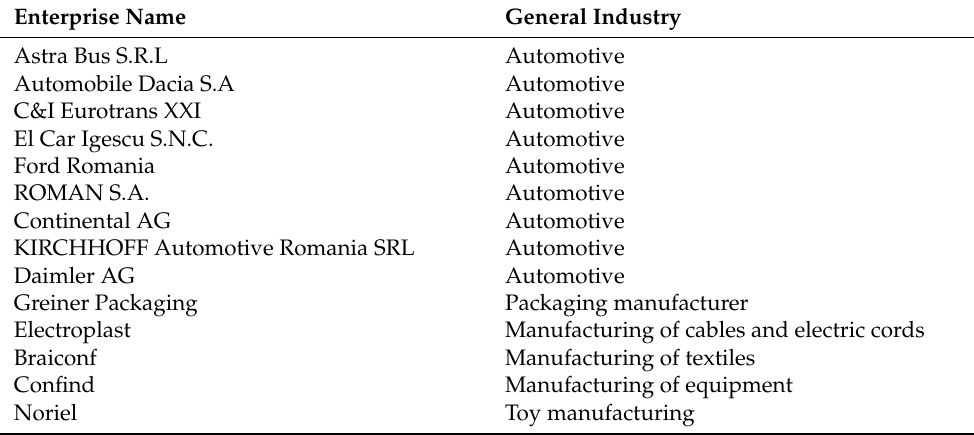
Table 4. Manufacturing enterprises in Romania. Source: Author’s contribution based on data retrieved from various sources, including Statista’s Most important companies in the manufacturing industry in Romania in 2019, by revenue report, available at